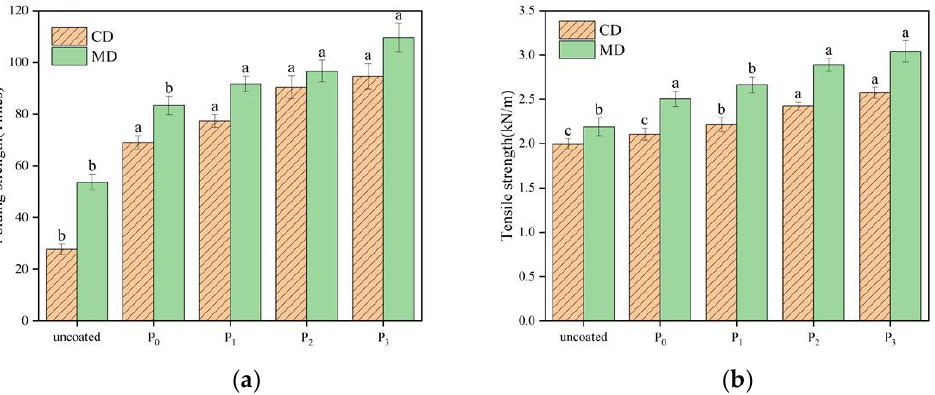
Figure 9. Folding strength ( a ) and tensile strength ( b ) of uncoated paper, PVA-coated paper and paper coated with PVA-CFEO-Ms at different concentrations. Data are expressed as the mean ± standard deviation ( n = 3). Different letters on the diagram indicate significant differences between groups at p < 0.05. CD = machine direction; MD = cross-machine direction.